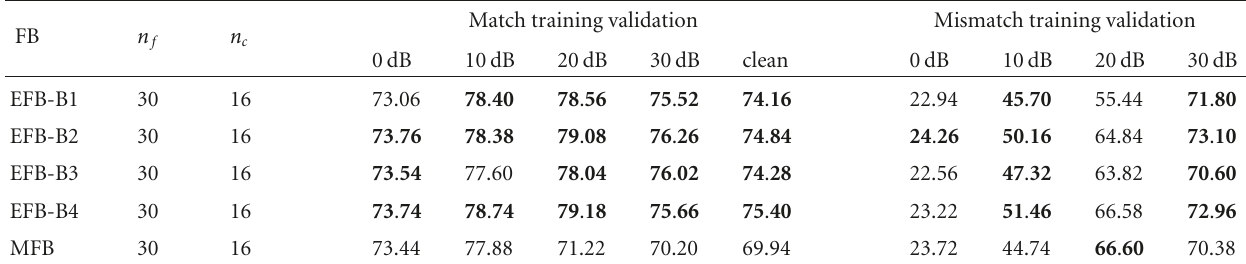
Table 2: Averaged validation results for phoneme recognition (shown in percent). Filterbanks are obtained from the optimization of filter center frequency and filter gain values and using clean signals.